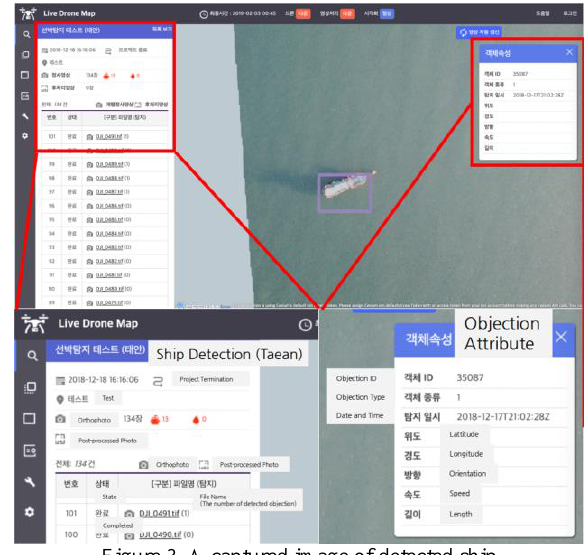
Figure 3. A captured image of detected ship on Live Drone Map website